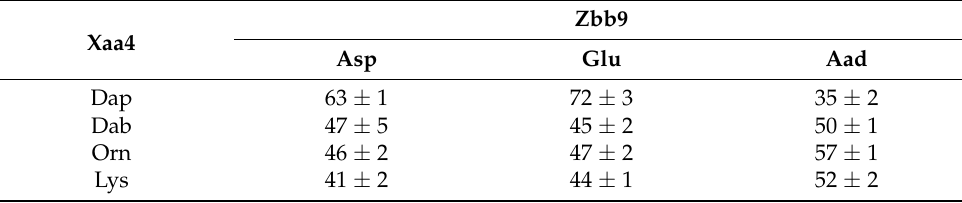
Table 1. The fraction folded population (%) for the HPTXaaZbb peptides 1 .